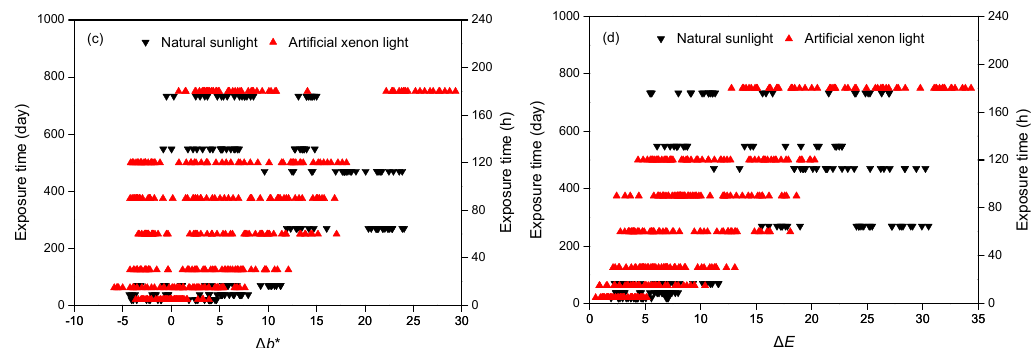
Figure 4. Correlation of color parameters between natural sunlight and artificial xenon light. ( a ) Δ L *; ( b ) Δ a *; ( c ) Δ b *; ( d ) Δ E.